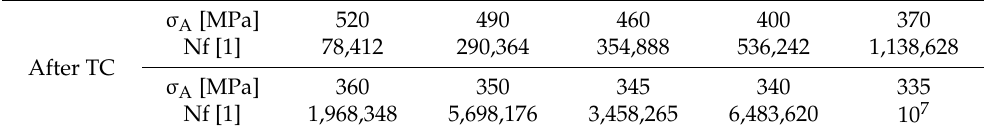
Table 4. Results of fatigue tests of samples with residual stress.